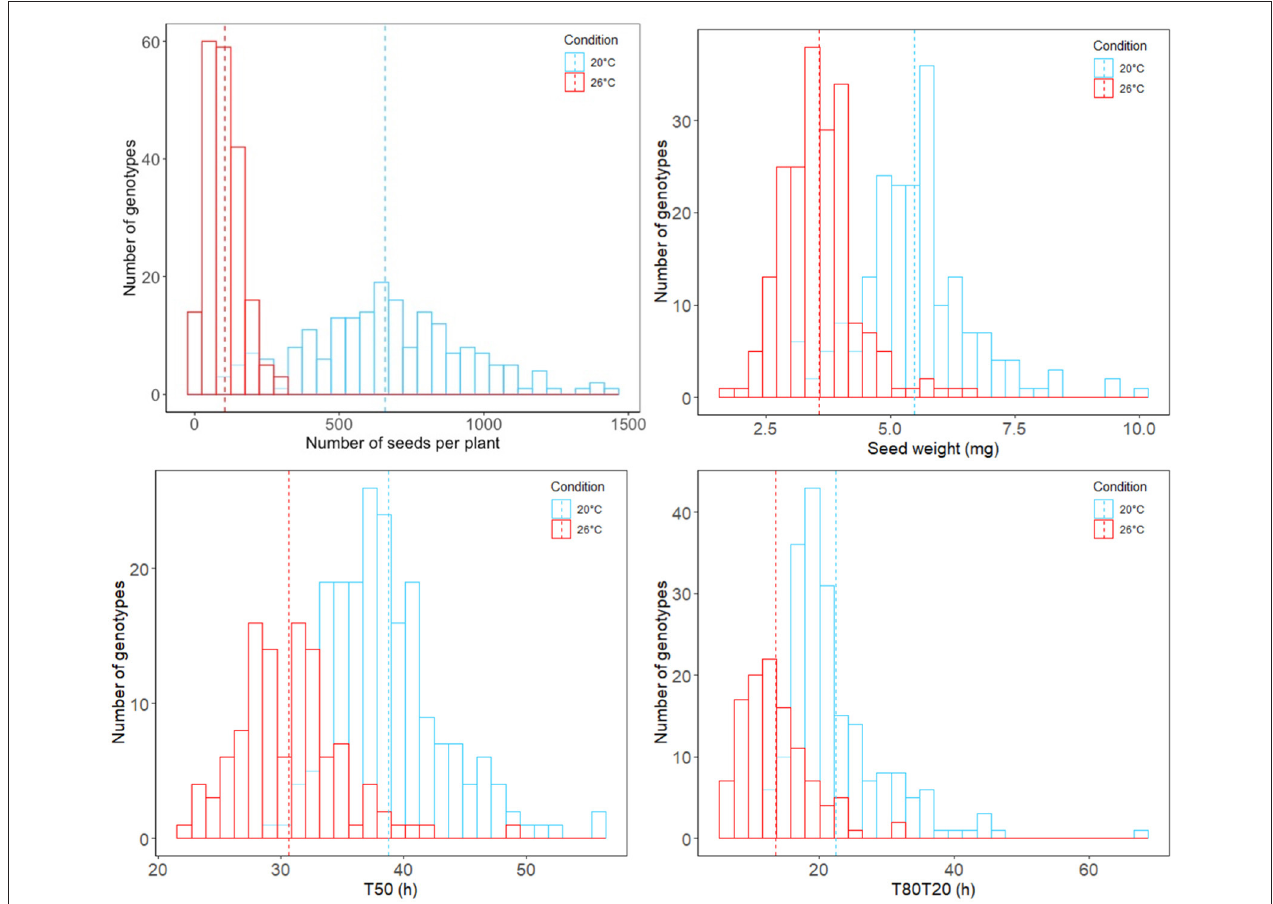
FIGURE 1 | Distribution histograms of analyzed phenotypic data regarding seed traits across the M. truncatula HapMap accessions and grown under optimal (blue) and heat stress (red) conditions. Average values across the entire HapMap population are represented in dotted